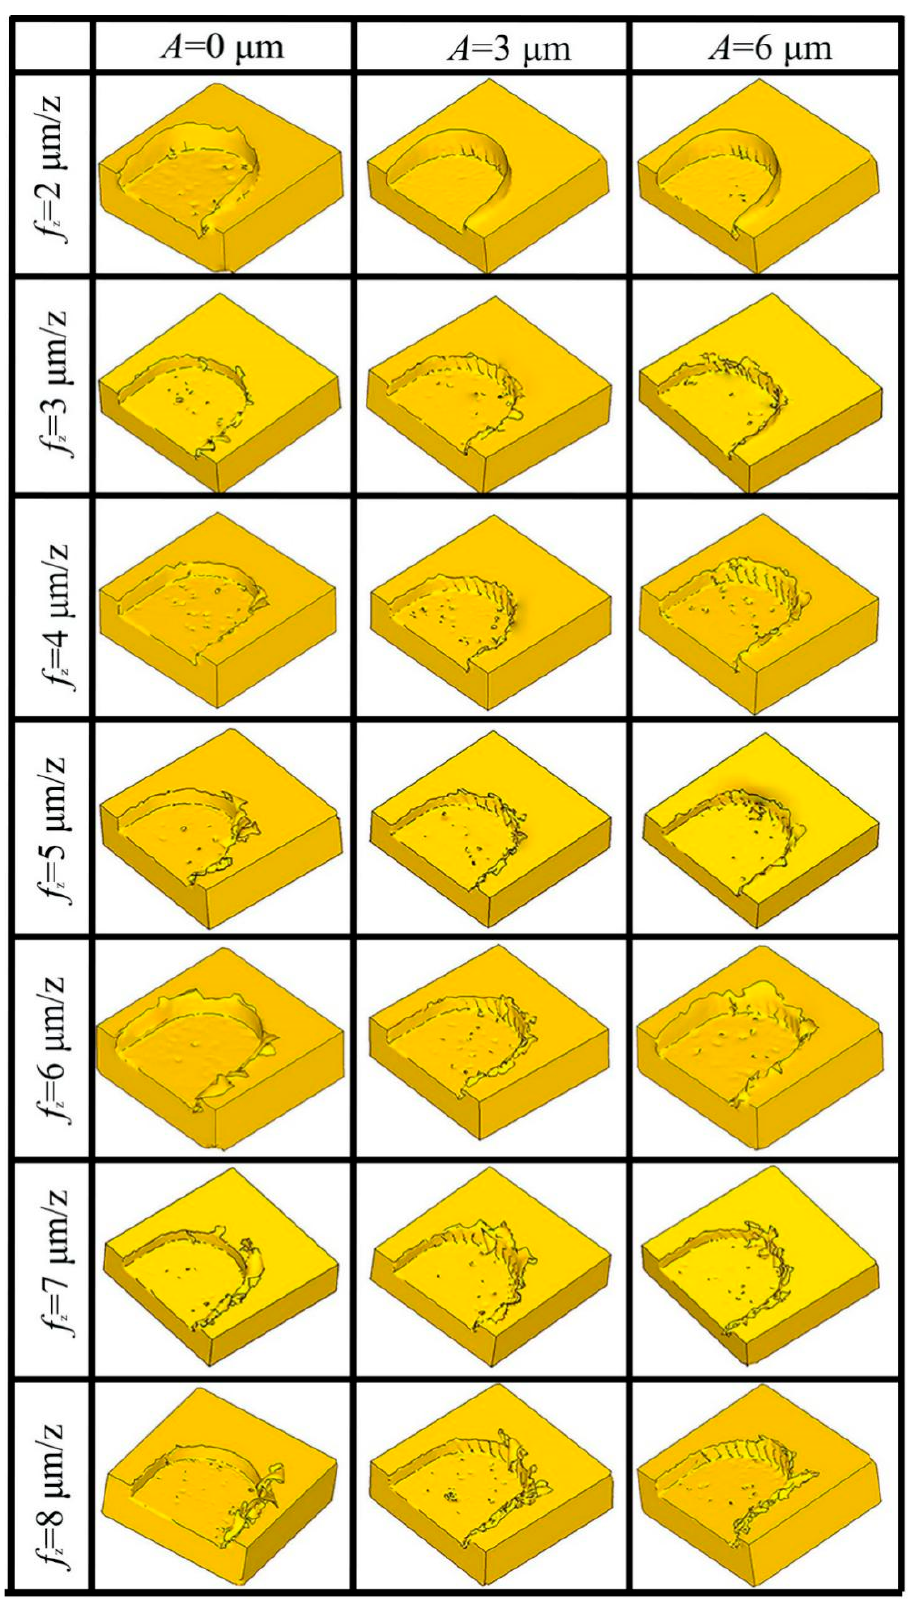
Figure 14. Simulation of burr morphology under different ƒ z .